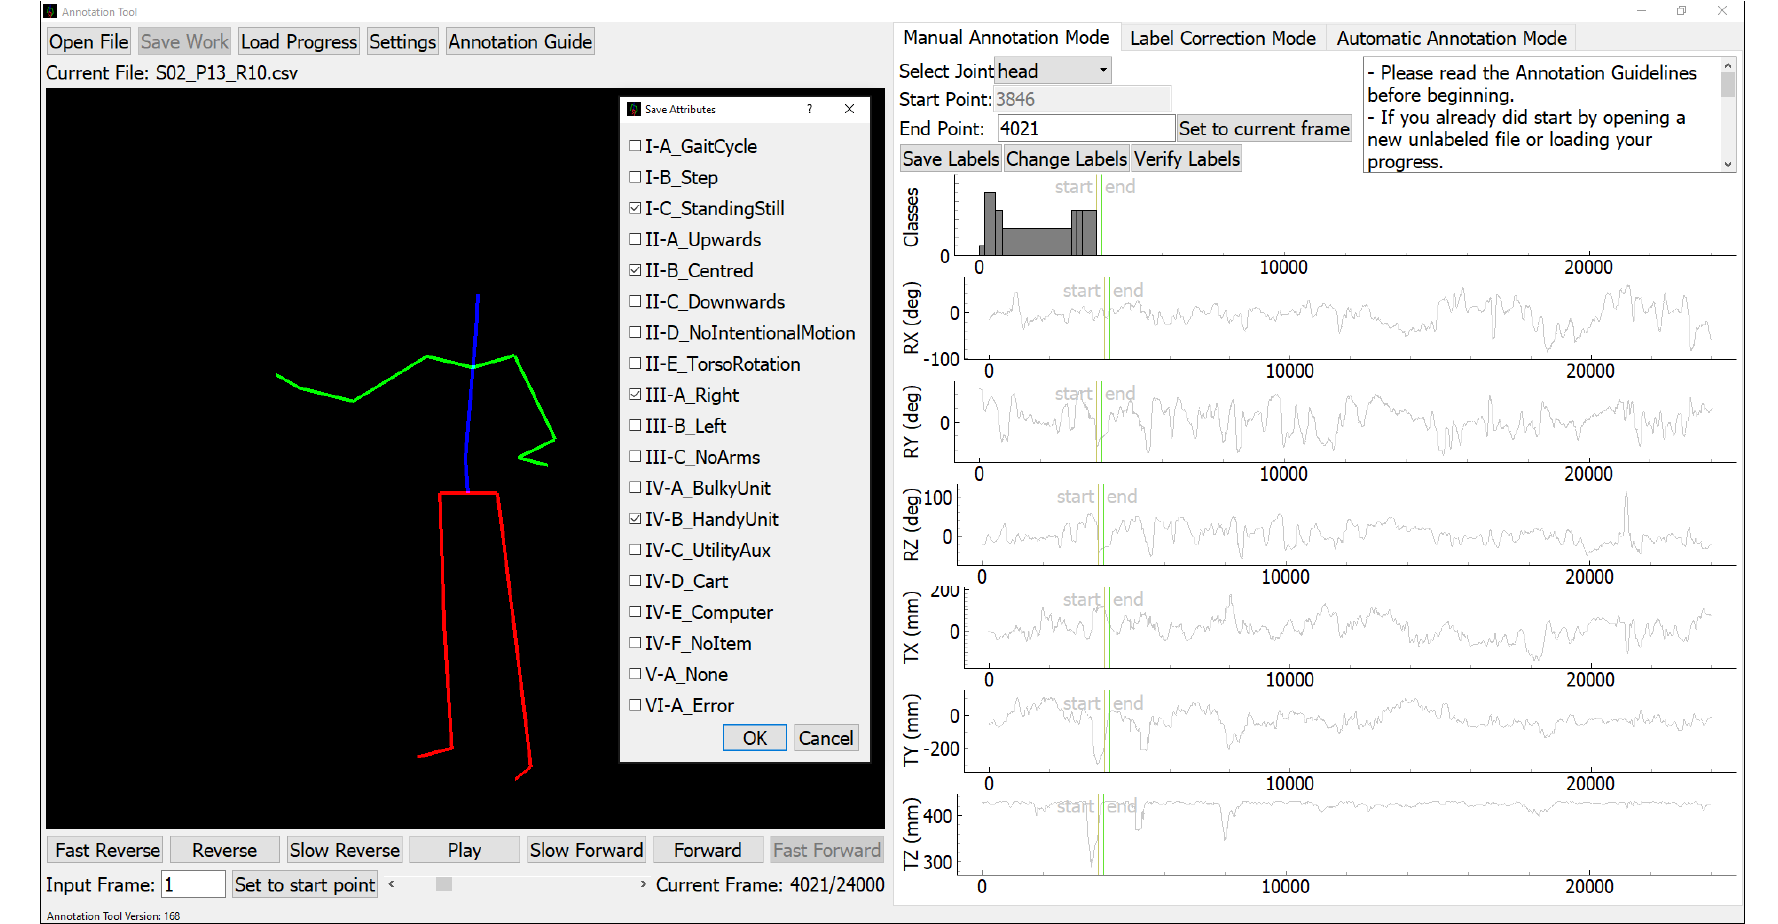
Figure A3. Screenshot of the annotation and revision tool during the